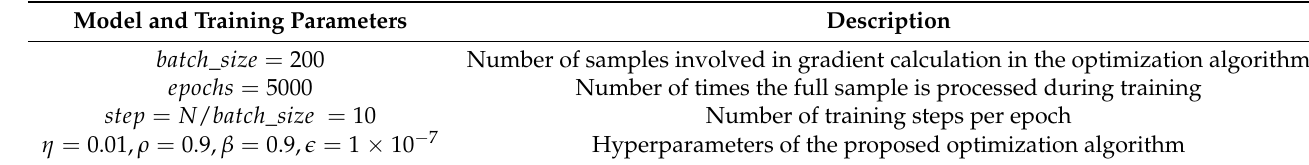
Figure 15. Comparison of learning curves between the proposed algorithm and MLE-ICA. Table 6. Model and training